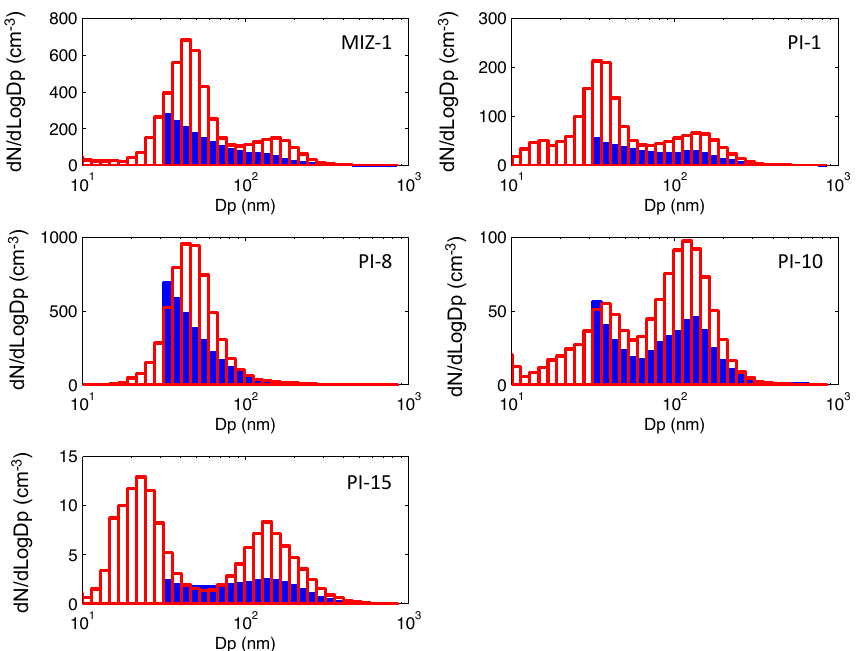
Figure 8. Comparison between TDMPS number size distribution (red) and converted mass size distributions (blue) for samples MIZ-1, PI-1, PI-8, PI-10 and